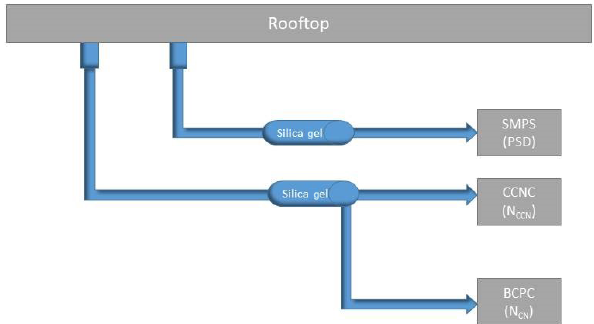
Figure 2. Schematic diagram for N CN , N CCN and particle size dis- tribution (PSD) measurements.